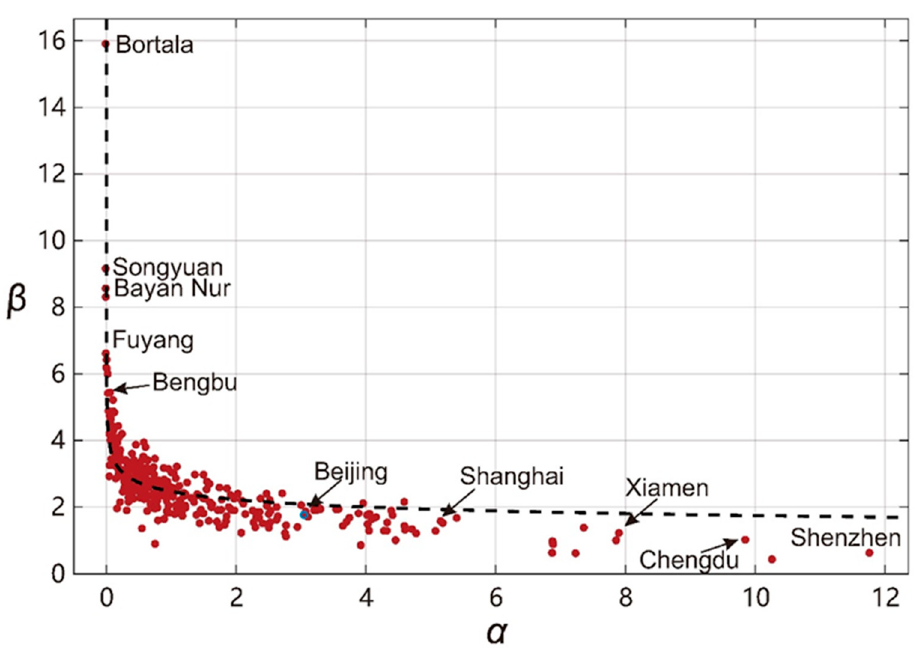
Figure 8. SSUDC coefficients ( α and β ) for 330 cities in Mainland China. Figure 8. SSUDC coe ffi cients ( α and β ) for 330 cities in Mainland